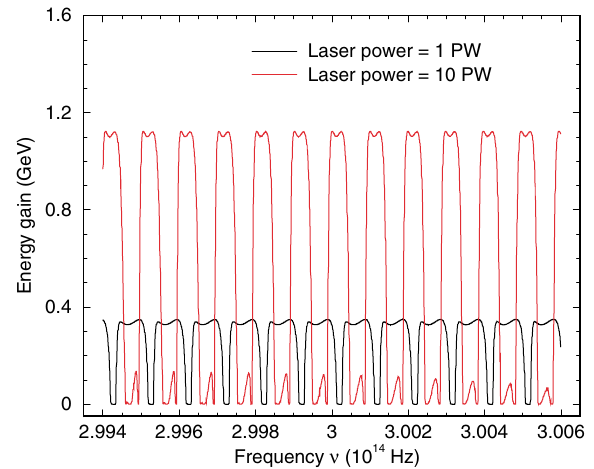
FIG. 13. (Color) Energy gain vs the laser frequency. The laser parameters and initial conditions on the electron injection are the same as in Fig.